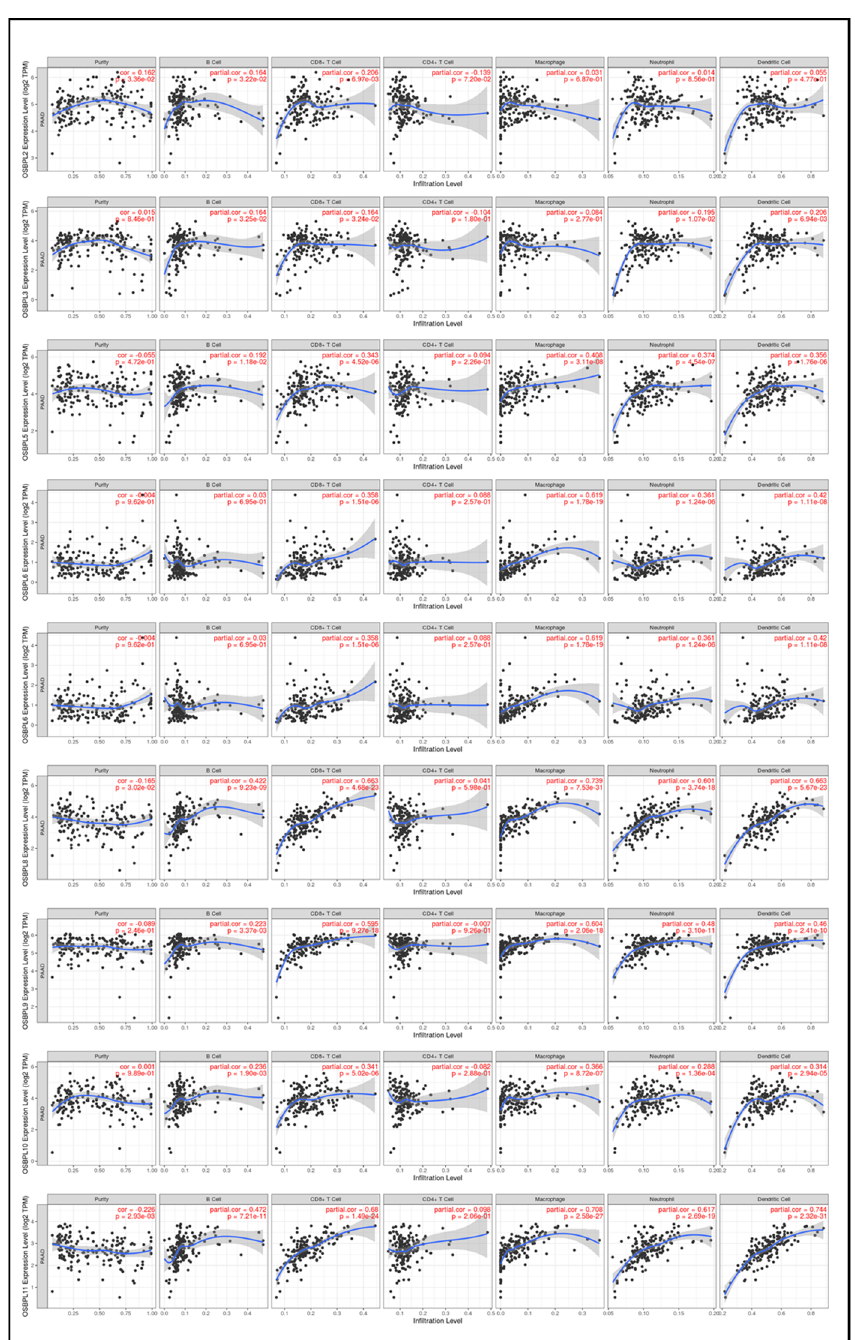
Figure 10. Association of expressions of oxysterol-binding protein-like (OSBPL) family members and tumor-infiltrating immune levels in pancreatic ductal adenocarcinoma (PDAC) using TIMER 2.0 data. The figures show the expression of each OSBPL family member with tumor purity and several tumor-infiltrating lymphocyte markers, such as B cell markers, CD8 + T cell markers, CD4 + T cell markers, macrophages, neutrophils, and dendritic cells. p < 0.05 was considered statistically significant.